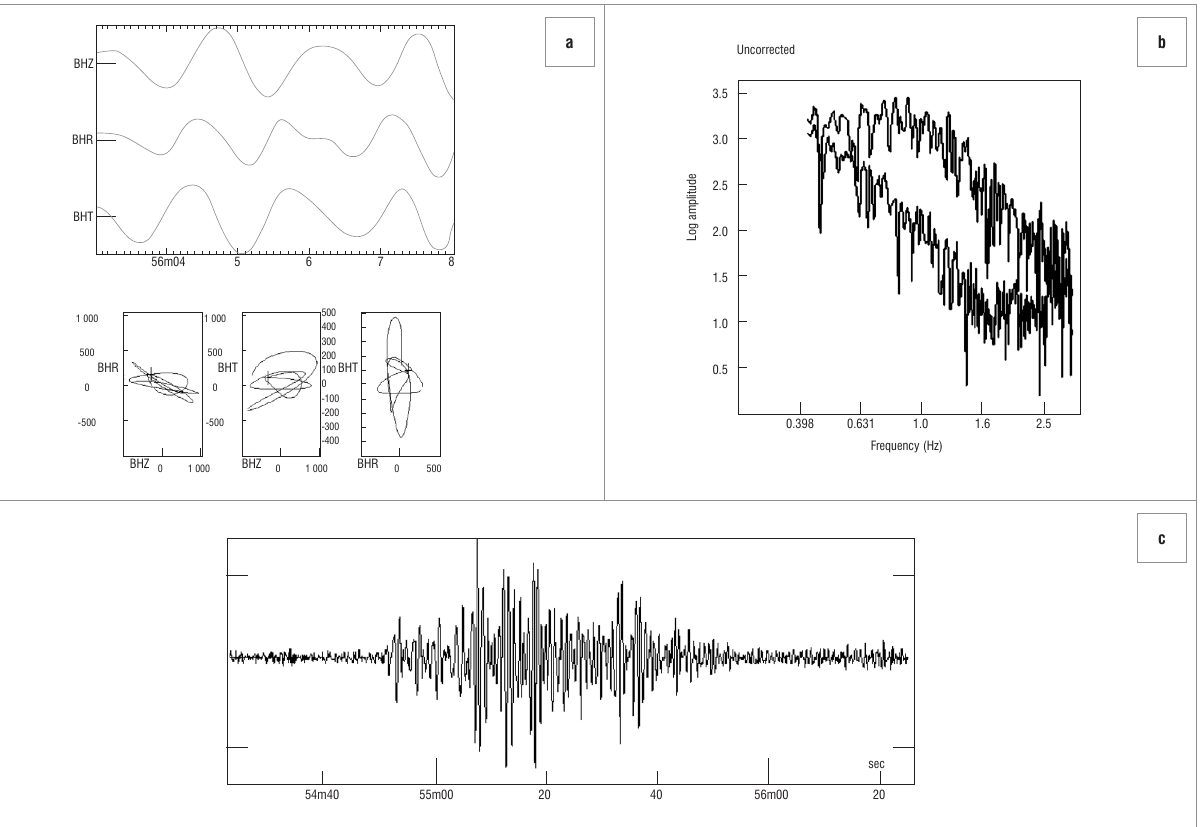
Figure 4: Detailed view of signal S1 showing (a) the particle motion, (b) the spectra of the signal and (c) the time